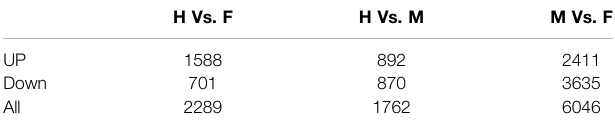
TABLE 2 | Result of differentially expressed gene. H Vs. F H Vs. M